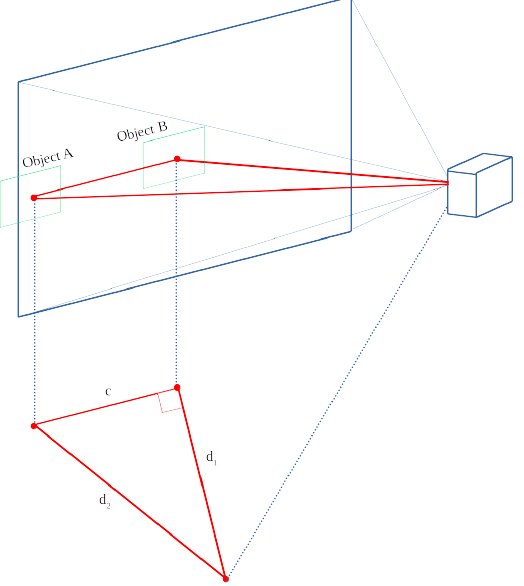
Figure 14. Projection of the camera, capturing the incoming